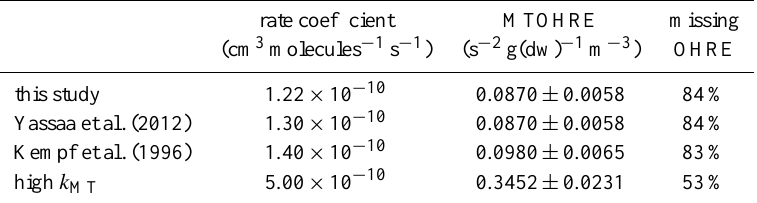
Table 3. Late summer results for various reaction rate coefficients being applied to the measured signal of total monoterpenes. Averages are given for the calculated OH reactivity emission rate due to monoterpenes (MTOHRE) and the missing fraction of OH reactivity emission rates